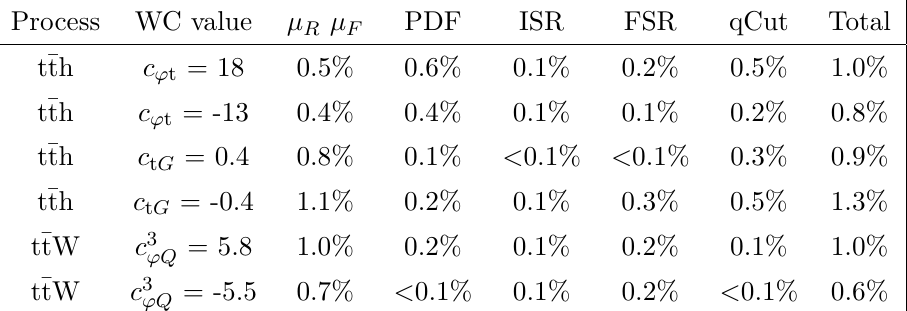
Table 4 . Examples of the relative sizes of the systematic uncertainties considered in this section. For each Wilson coefficient shown, the symmetrized fractional uncertainty for each systematic at the limits from [9] is listed.